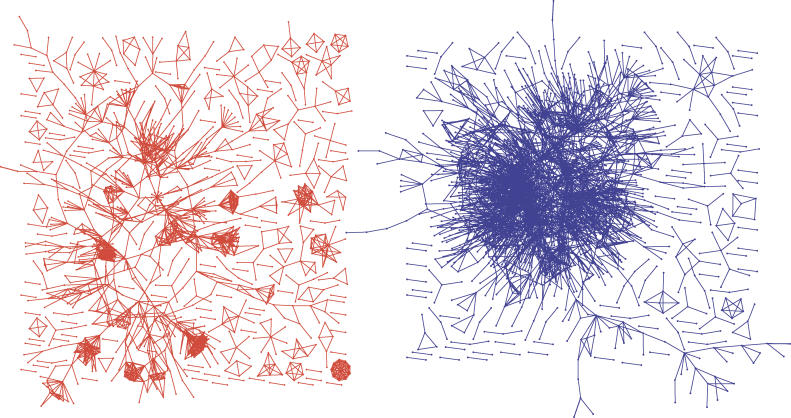
Global organization of yeast interaction networks. The smaller filtered yeast interactome (FYI) network (left) contains locally dense regions that are sparsely interconnected, whereas the larger high-confidence FYI (HCfyi) network (right) is densely interconnected overall, suggestive of extensive coordination and dependencies among diverse processes.